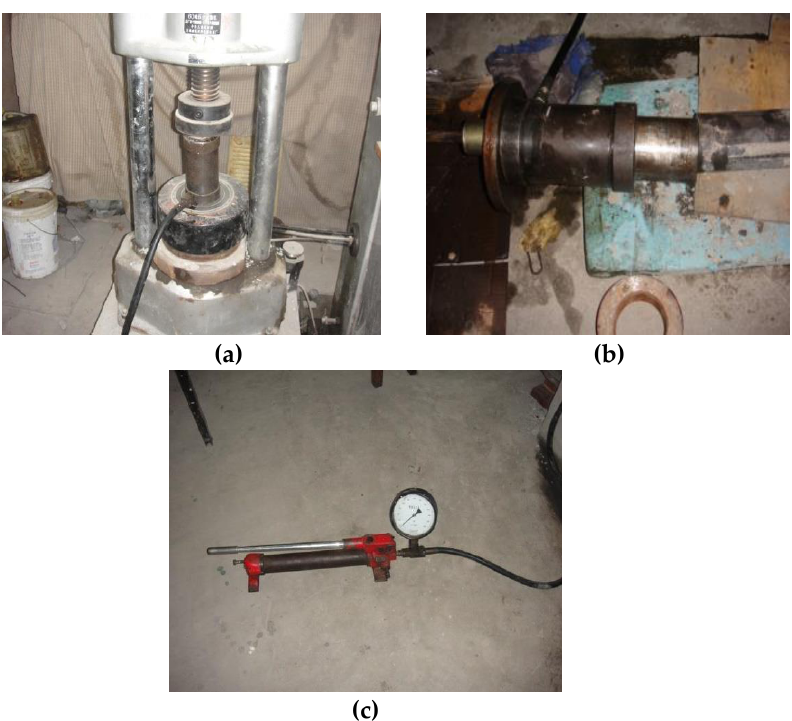
Figure 6. Anchor pull force test: ( a ) puller proofreading; ( b ) puller and test piece interface; ( c ) manual oil pump.